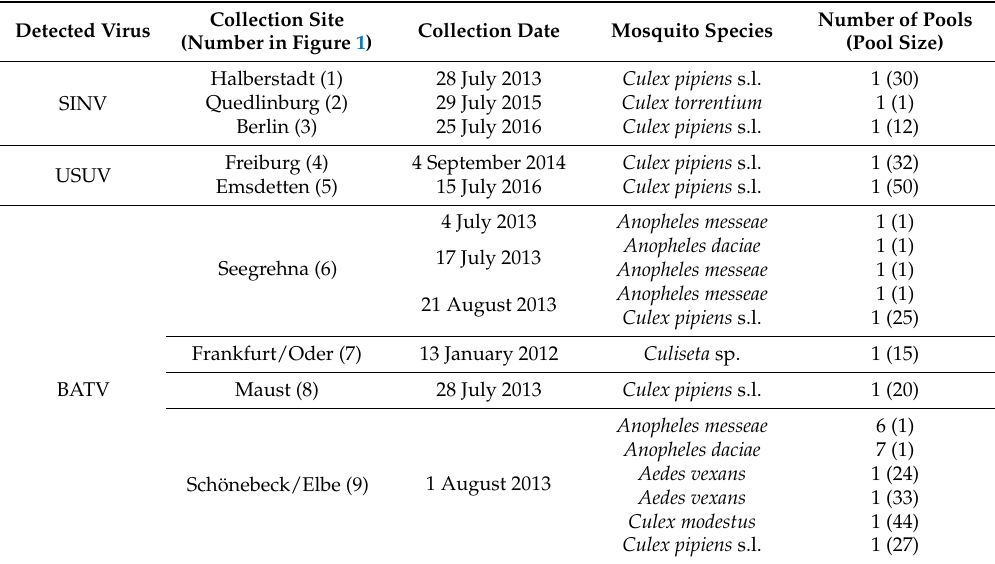
Table 1. Mosquitoes tested positive for zoonotic arbovirus-RNA. The abbreviation s.l. (= sensu lato) marks species complexes. Collection site numbers in parentheses refer to locations in Figure